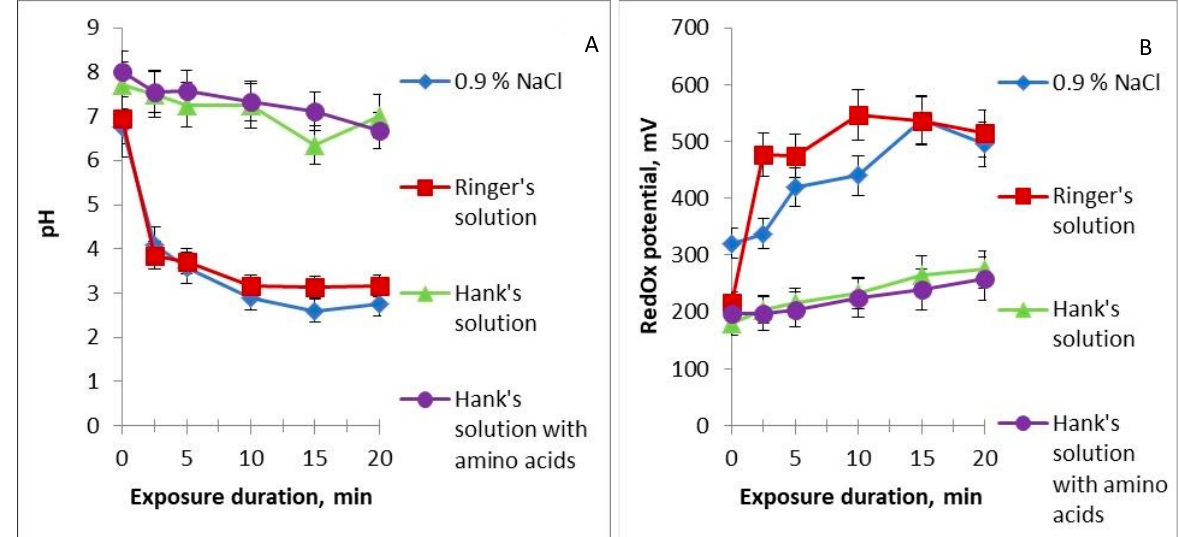
Figure 3. Dependence of pH ( A ) and redox potential ( B ) of the studied solutions on the time of their treatment with cold plasma.